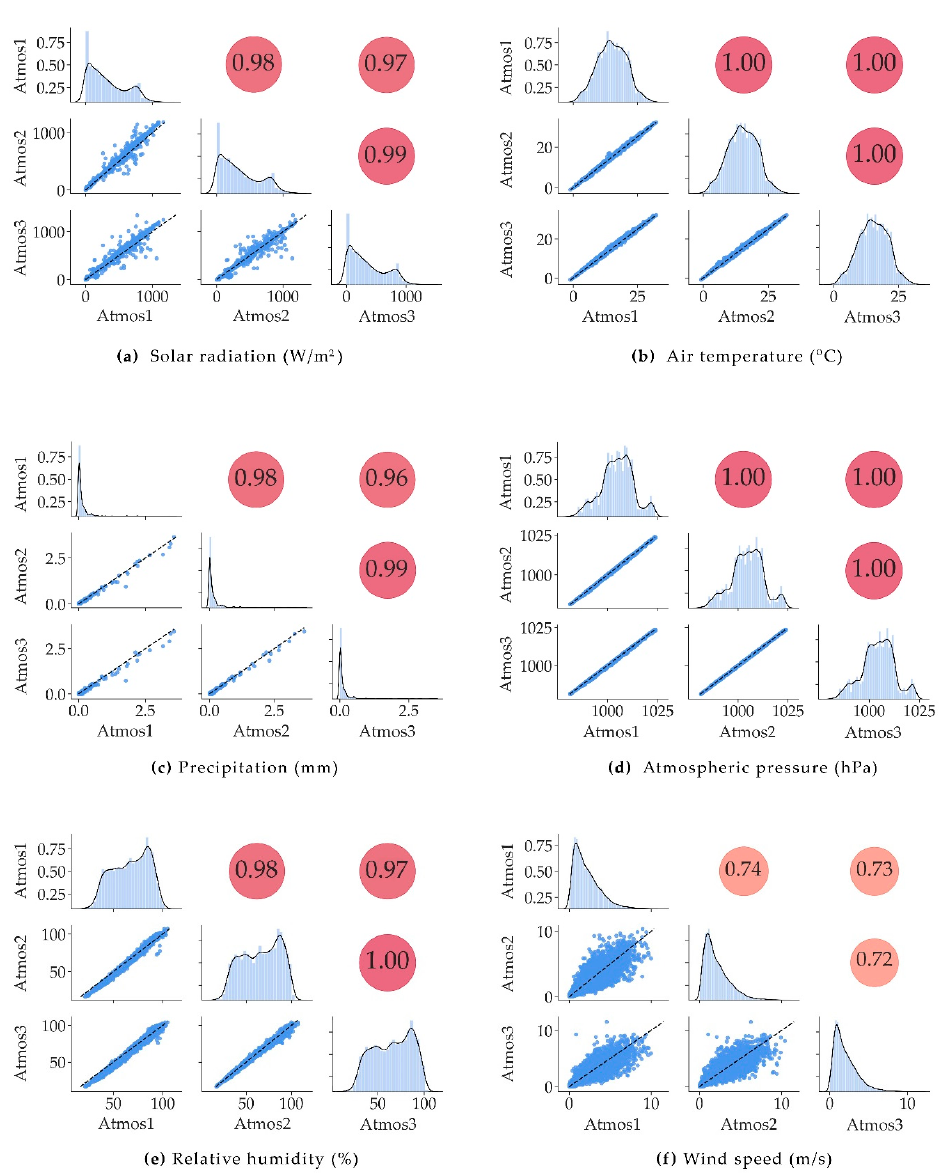
Figure 3. ( a – f ) Correlation matrices for all weather variables measured by the three ATMOS41 stations. Subplots in the lower left show scatterplots of station pairs with the dashed line indicating the 1:1 identity line, the diagonal shows histograms of measured values with probability density functions, upper right shows the coefficient of determination R 2 .